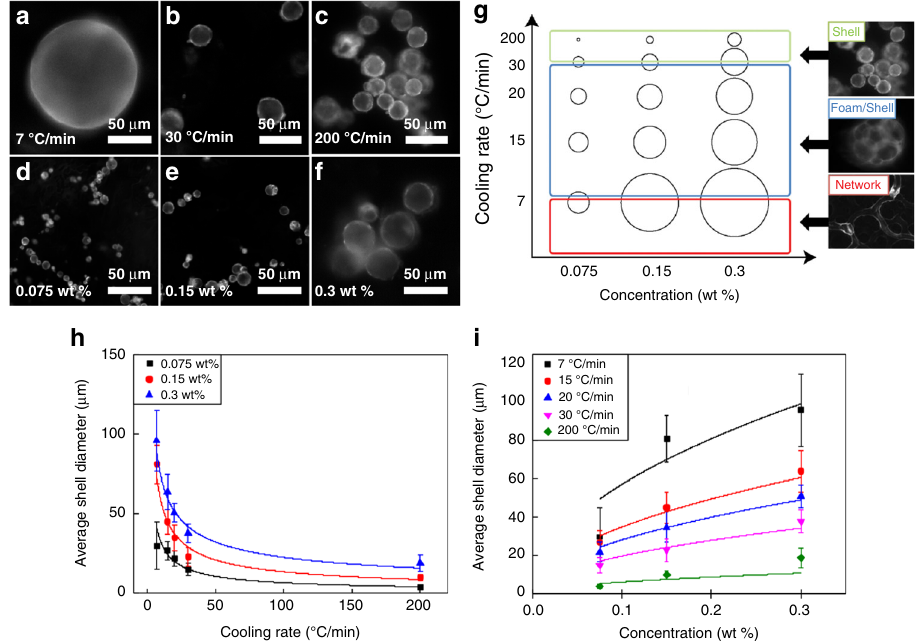
Fig. 2 Size dependence on cooling rate and nanoparticle concentration. Representative fl uorescence microscopy images of spherical shells formed from ligand-modi fi ed quantum dots (LC-QDs) at a – c fi xed LC-QD concentration of 0.3 wt% in 5CB, varying cooling rate, and d – f fi xed cooling rate of 200 °C min − 1 , varying LC-QD concentration in 5CB. g Qualitative phase diagram for the three distinct morphologies predominantly observed as a function of cooling rate and concentration. General morphological zones on the diagram are indicated by the colored boxes with circle size representative of structure size. h , i Plots of average shell diameter vs. cooling rate and concentration respectively, with error bars indicating standard deviation (s.d.); the total number of measured structures, n , ranged from 10 to 183 (Supplementary Table